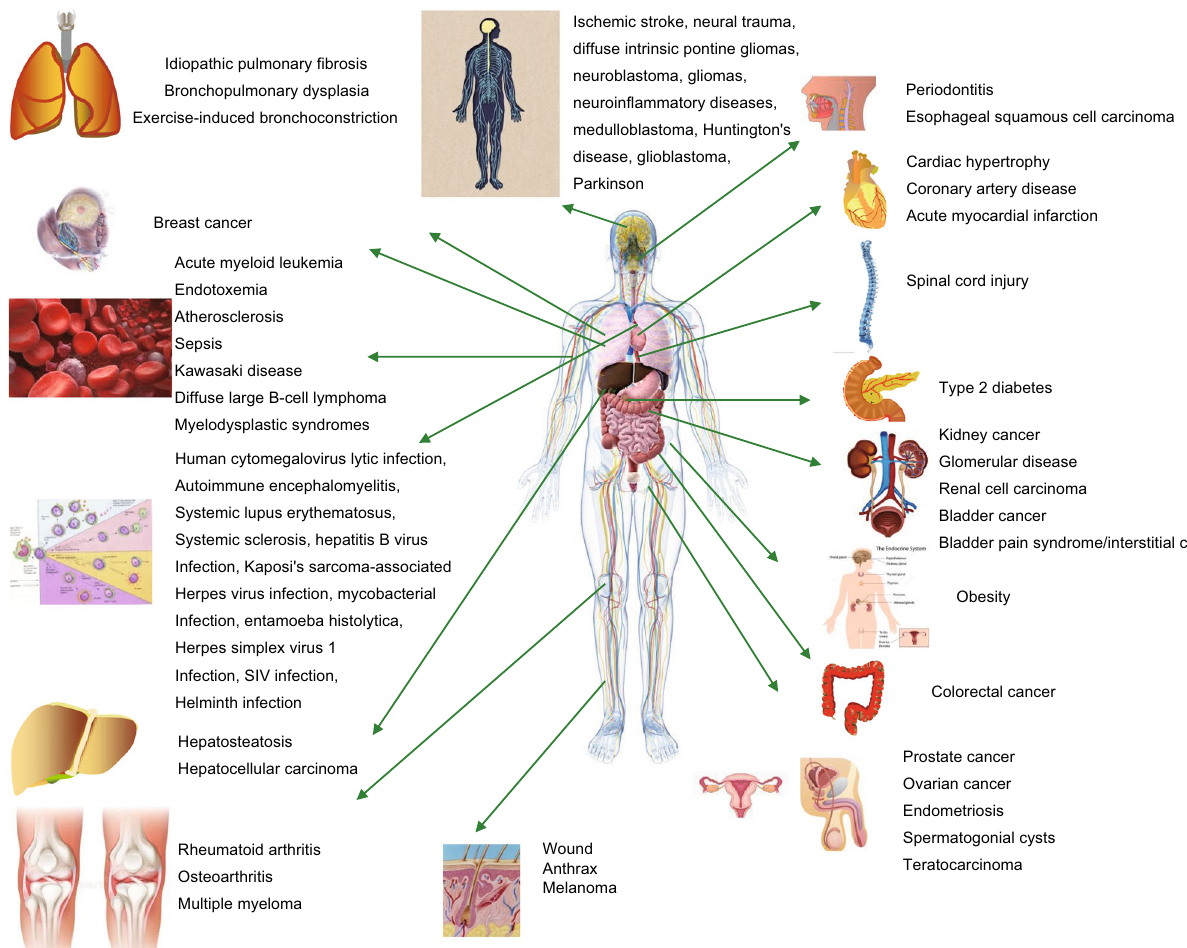
Figure 3. Schematic diagram illustrating human diseases associated with JMJD3. This map highlights those biological processes that have been proven to be related to human pathology (see text for references), and indicates that JMJD3 has been proven to be a therapeutic target or a biomarker of disease or